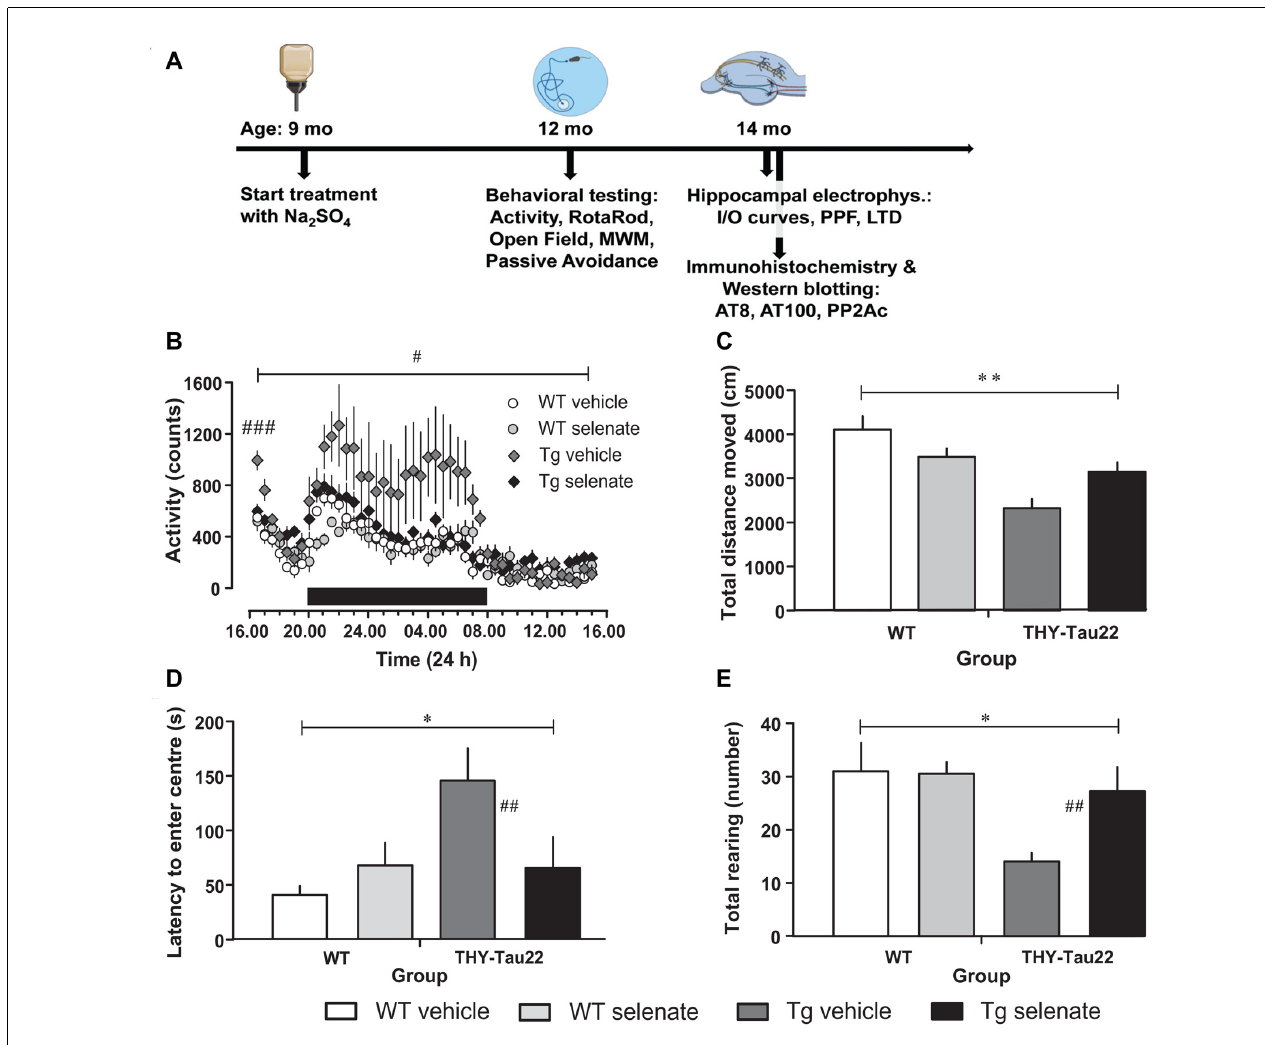
FIGURE 1 | Selenate treatment restores behavioral and neurocognitive deficits in THY-Tau22 (henceforth referred to as Tg) mice to levels comparable with wildtype (WT) controls. (A) Timeline of the experiments. The behavioral experiments started at the age of 12 months, the electrophysiological examination at 14 months. At the same time, tissue samples were collected for immunohistochemistry and Western blotting. (B) Analysis of cage activity revealed higher activity of Tg mice at the beginning of the recording period and increased nocturnal activity as compared with WT controls. These differences were abolished by chronic selenate treatment. Note that selenate treatment did not affect WT animals. (C–E) Open-field behavior. Tg animals traveled less in the arena (C) showed higher latencies to enter the center of the arena (D) and displayed less exploratory rearings in the center (E) as compared with WT mice. Selenate treatment remediated these behavior changes. Mean ± SEM is given; group sizes: cage activity n = 10 per group; open field test Tg-veh n = 9, Tg-sel n = 10, WT-veh n = 8, WT-sel n = 10. Bar with # indicates the significance level p ≤ 0.05 in RM-ANOVA with a Dunnett post hoc test using Tg vehicle as comparison; bars with a ∗ and ∗∗ indicate p ≤ 0.01 and p ≤